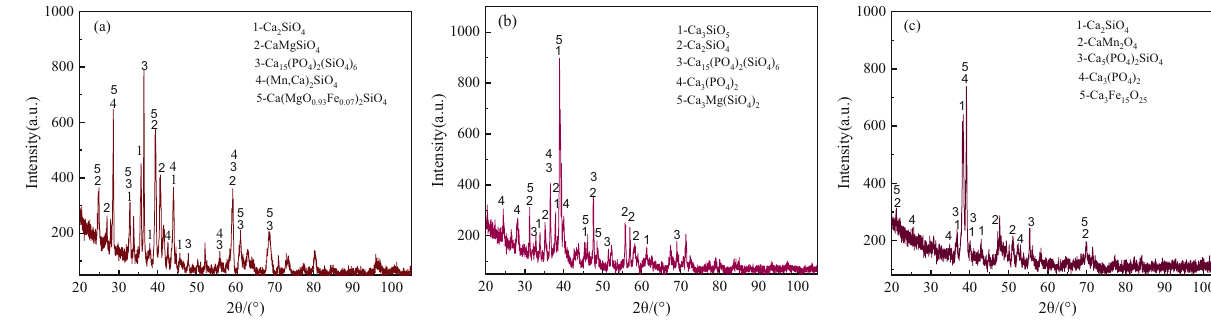
Figure 7: XRD results of the reduced slag (( a ) R = 1.0; ( b ) R = 1.5; ( c ) R = 2.0 ) .